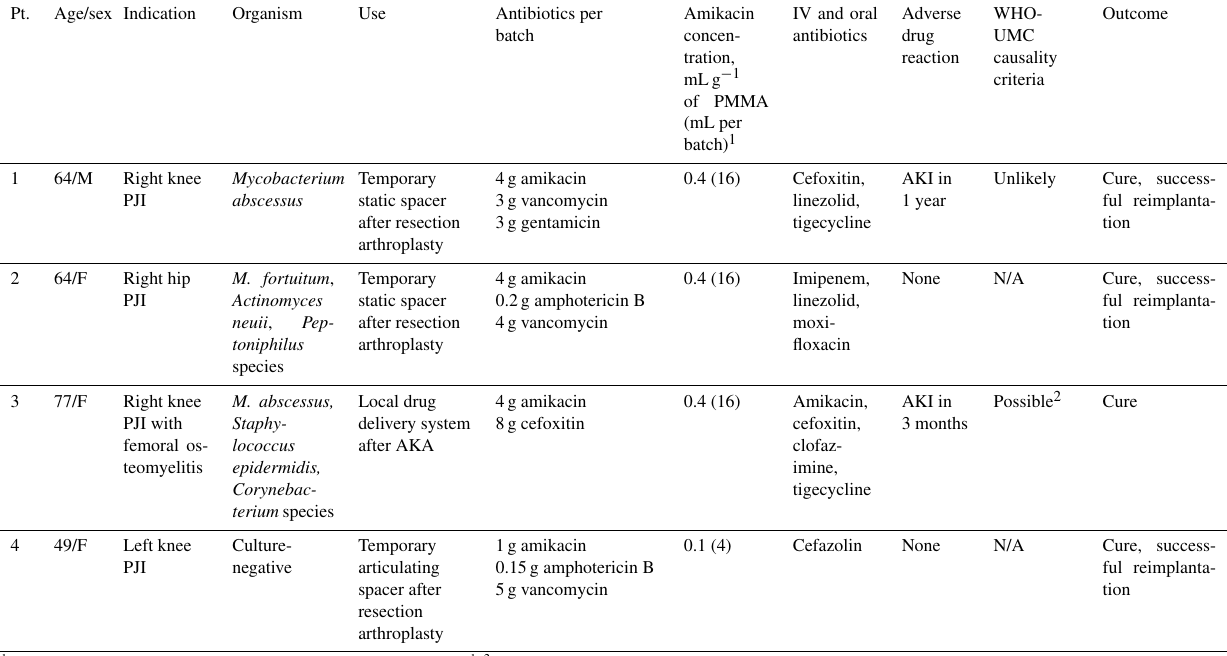
Table 1. Summary of patients in whom amikacin-loaded bone cement was used. Pt. Age/sex